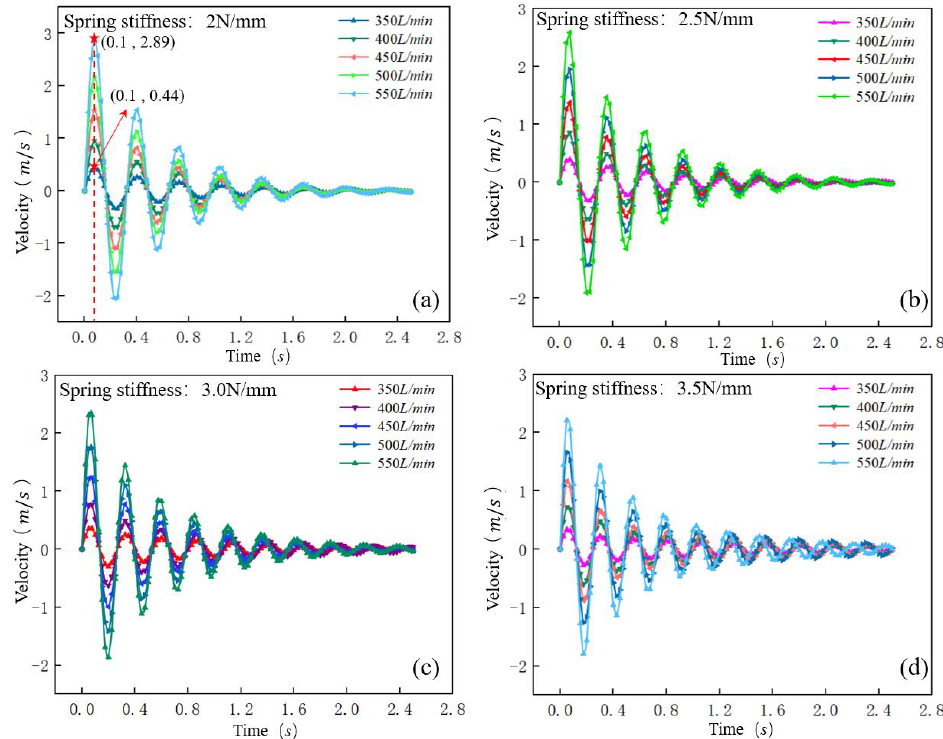
Figure 6. The sliding core movement velocity changes with spring stiffness and drilling fluid flow: ( a ) Spring stiffness 2 N/mm; ( b ) Spring stiffness 2.5 N/mm; ( c ) Spring stiffness 3.0 N/mm; ( d ) Spring stiffness 3.5 N/mm.